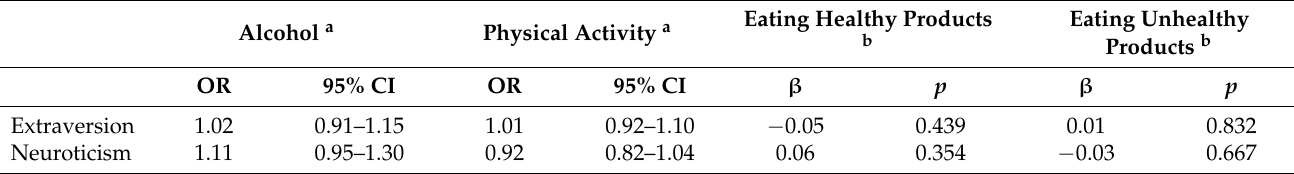
Figure 3. The interaction effect of time and extraversion on eating regularity ( p < 0.05). Associations of personality traits with perceived change in health behaviors are shown in Table 4 for the onset of the emergency conditions (in-pandemic-I) and in Table 5 for the end of the emergency conditions (in-pandemic-I). At the onset of emergency conditions, personality traits were not related to a perceived change in health behaviors. At the end of the emergency conditions, women who scored higher in extraversion were more likely to report a decrease in their alcohol consumption. In addition, women with higher scores in neuroticism were more likely to report a change in their eating behavior, i.e., they reported either a change to healthier or unhealthier eating habits compared to women with lower neuroticism. Women scoring high in extraversion were more likely to report a healthier change in their eating habits. There were no differences between decrease and increase (physical activity) or unhealthier and healthier (eating habits) groups in the multinomial regression analyses. Table 4. Associations of personality traits with perceived changes in health behaviors at the onset of emergency conditions ( n =